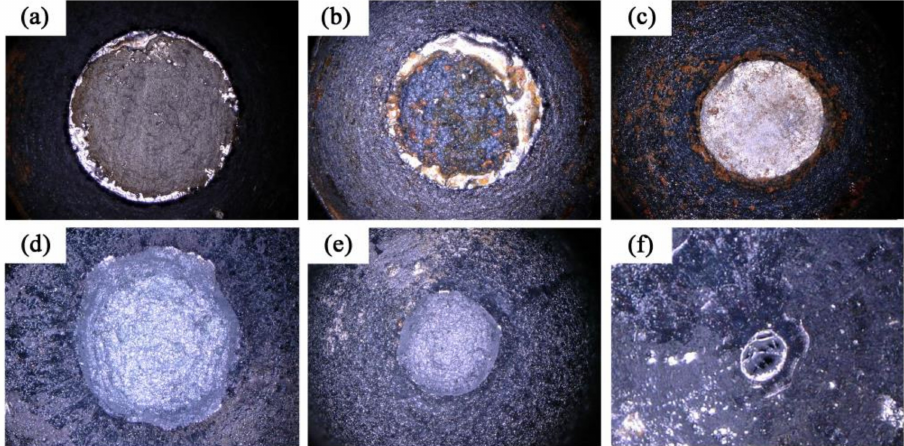
Figure 2. The typical fracture morphology of VL steel after hot tensile tests at different temperatures and strain rates: ( a ) 10 − 3 s − 1 , 600 ◦ C; ( b ) 10 − 3 s − 1 , 900 ◦ C; ( c ) 10 − 3 s − 1 , 1200 ◦ C; ( d ) 10 s − 1 , 600 ◦ C; ( e ) 10 s − 1 , 900 ◦ C; ( f ) 10 s − 1 , 1200 ◦ C.